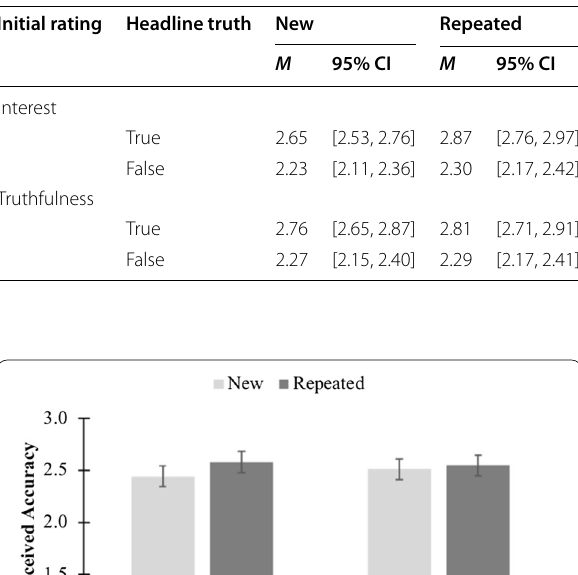
Table 1 Mean perceived accuracy based on whether headlines were true or false, whether they were new or repeated, and whether the initial ratings were about interest of truthfulness from Experiment 1